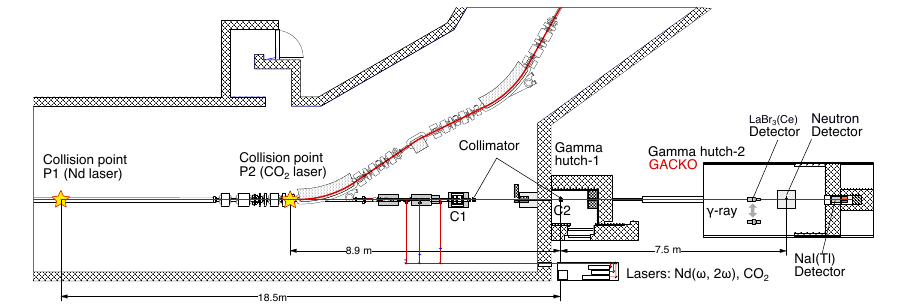
Figure 2. (Color online) γ -ray beam line of the NewSUBARU facility.